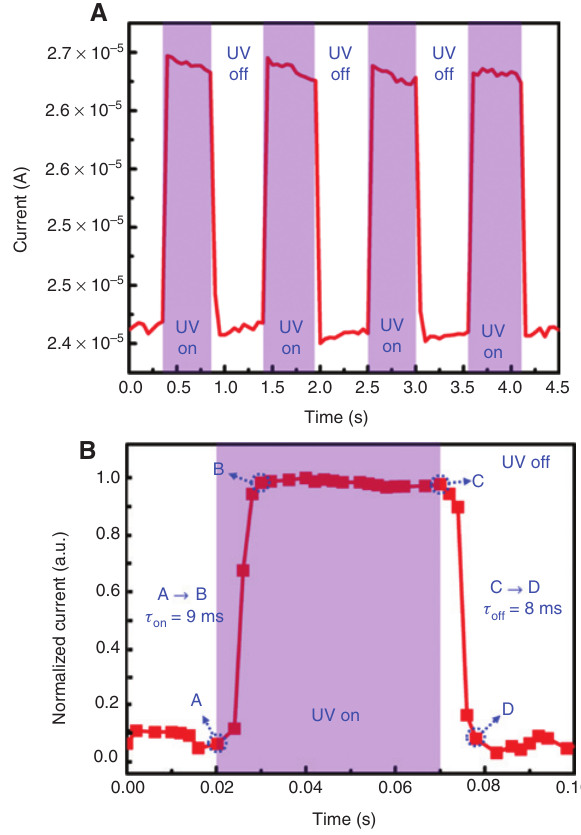
Figure 5: Transient response of PDs to 254 nm illumination at the bias of −5 V. (A) Response for multicycles and (B) normalized response on a linear scale.